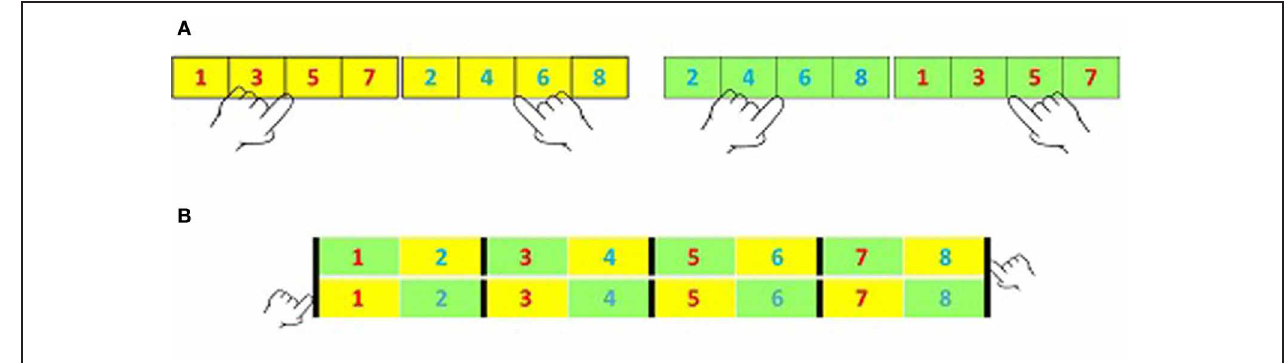
FIGURE 1 | (A) The two mappings of parity. (B) The post-experimental classification of